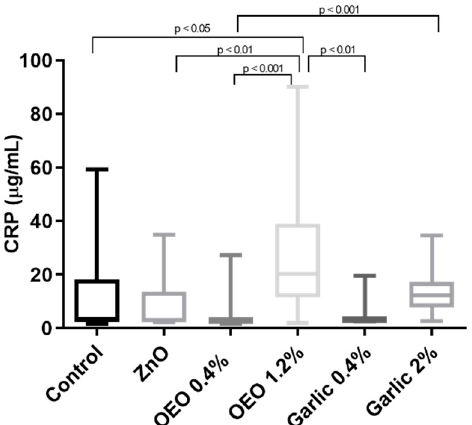
Figure 4. Results for serum C-reactive protein (CRP) in piglets supplemented with ZnO, micro capsuled OEO at a concentration of 0.4% in the basal diet, micro capsuled OEO at a concentration of 1.2% in the basal diet, garlic powder at a concentration of 0.4% in the basal diet, and garlic powder at a concentration of 2% in the basal diet. The plots show median (line within box), 25th and 75th percentiles (box), and minimum and maximum values (whiskers).